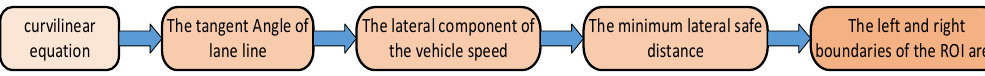
Figure 5. Horizontal constraint flow chart.